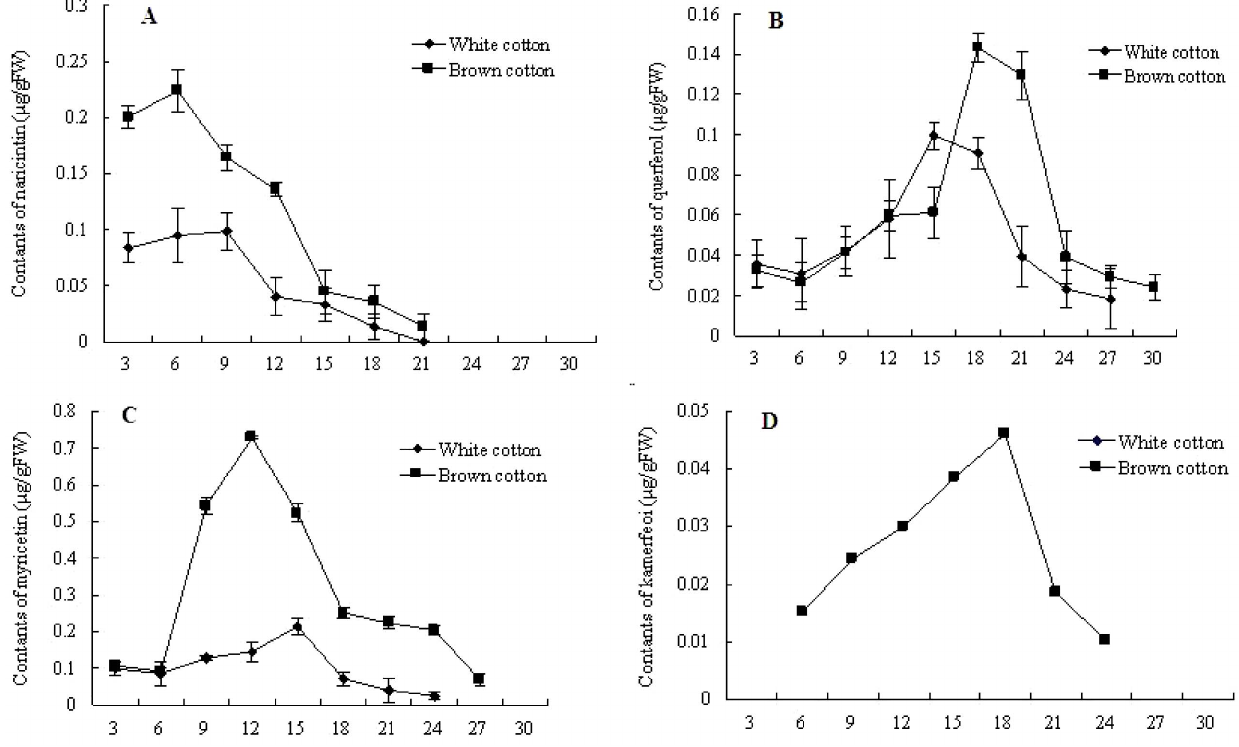
Figure 6. The contents of four flavonoids during the development of brown and white cotton fiber. A: naringenin, B: quercetin, C: myricetin, D: kaempferol. The numbers in horizontal axis represent 3, 6, 9, 12, 15, 18, 21, 24, 27, 30 DPA fiber cells, respectively.